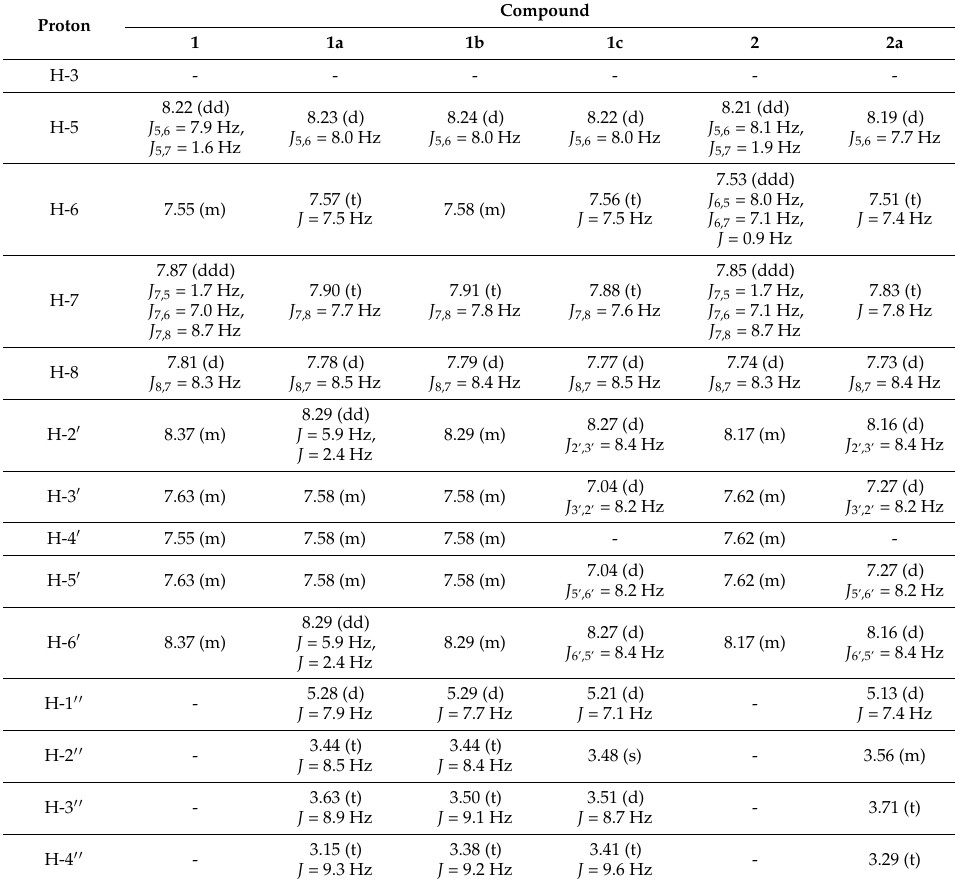
Table 1. 1 H-NMR shifts ( δ ) of 3-hydroxyflavone ( 1 ) and 3-methoxyflavone ( 2 ) and products of